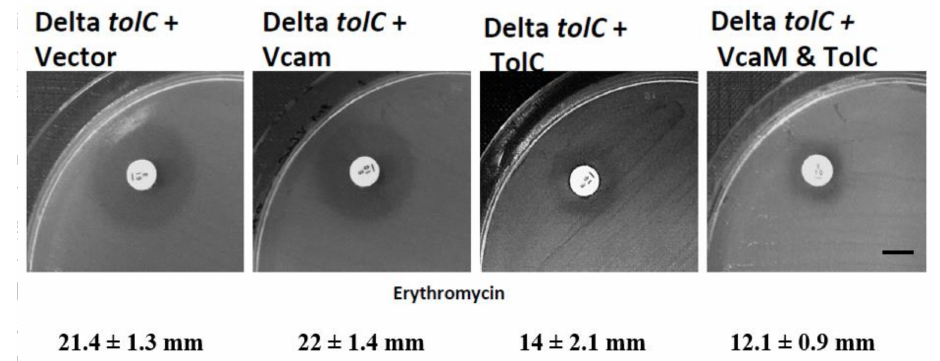
Figure 7. Representative disk diffusion assay results demonstrating the VcaM dependency on TolC. 10 µ g impregnated erythromycin disk was placed and incubated at 37 ◦ C overnight. 2.6. Periplasmic Adapter Proteins Might be Needed for V. cholerae VcaM to Provide TolC-Dependent